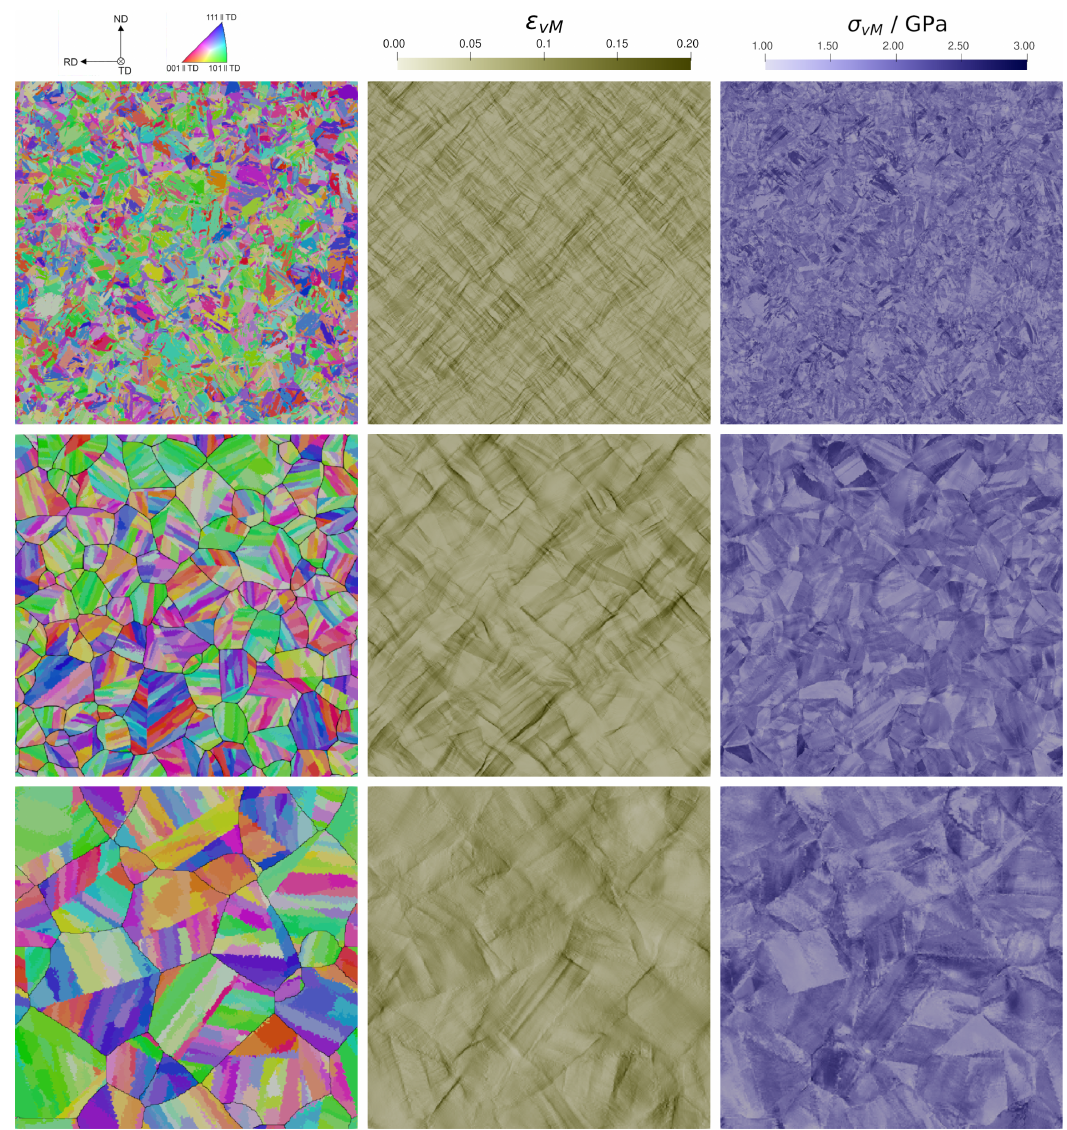
Figure 9. Spatially resolved results for the experimental microstructure of size 400µm 2 ( top ), a 2D Representative Volume Element (RVE) of size 300µm 2 ( middle ) and a 3D RVE of size 128µm 3 ( bottom